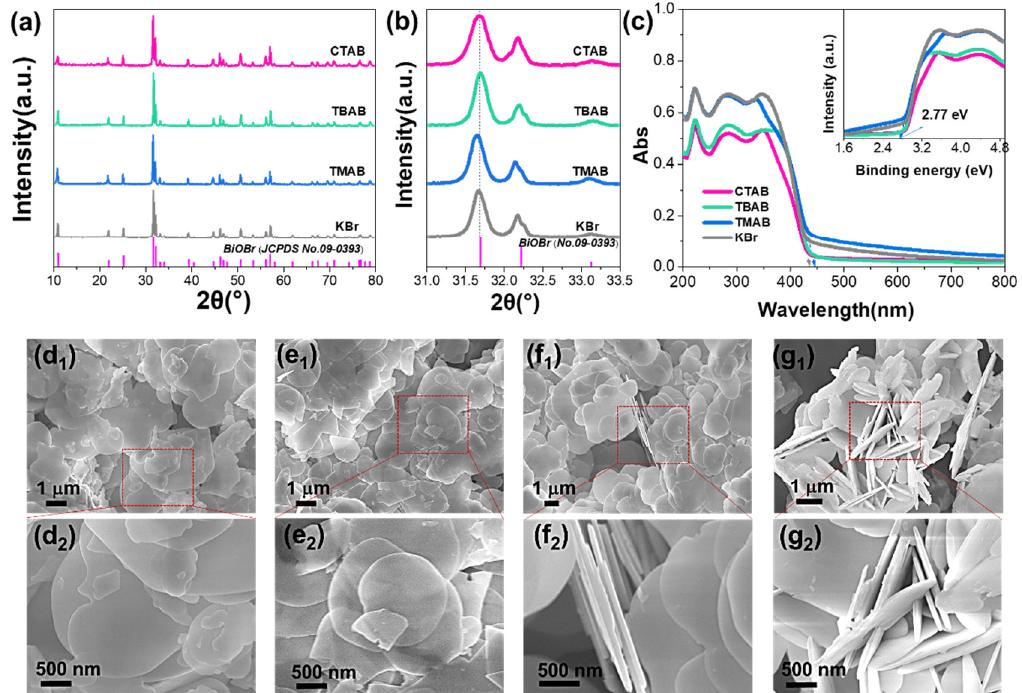
Figure 1. Comparison of products obtained by altering the bromide ion sources, ( a ) XRD patterns; ( b ) corresponding enlarged range of 31–33.5 ◦ . ( c ) DRS spectra (inset with corresponding estimated bandgaps). SEM images of ( d 1 ) and ( d 2 ) KBr, ( e 1 ) and ( e 2 ) TMAB, ( f 1 ) and ( f 2 ) TBAB, and ( g 1 ) and ( g 2 )